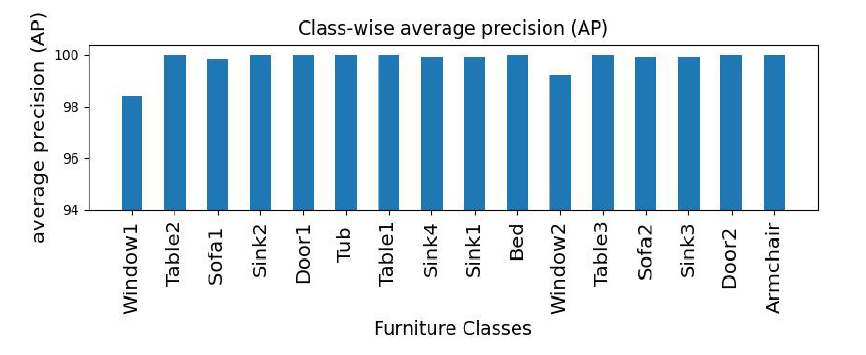
Figure 6. Class-wise average precision (AP) results of 5 data folds with 10% label data using Mask R-CNN [17] with ResNet-101 [19]